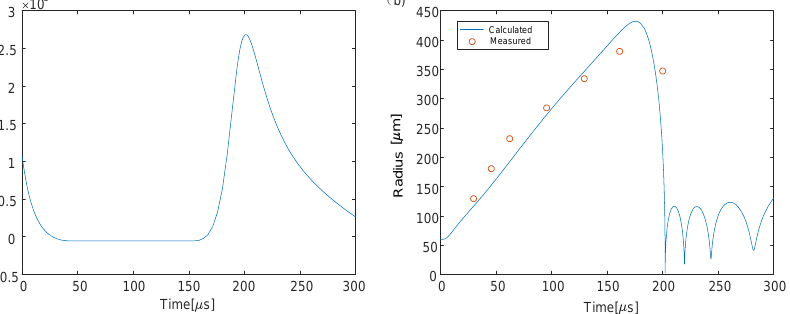
Figure 2. Slap pressure and the induced bubble radius evolution. ( a ) Pressure induced by slap forces. ( b ) Comparison of bubble radius between measurement and